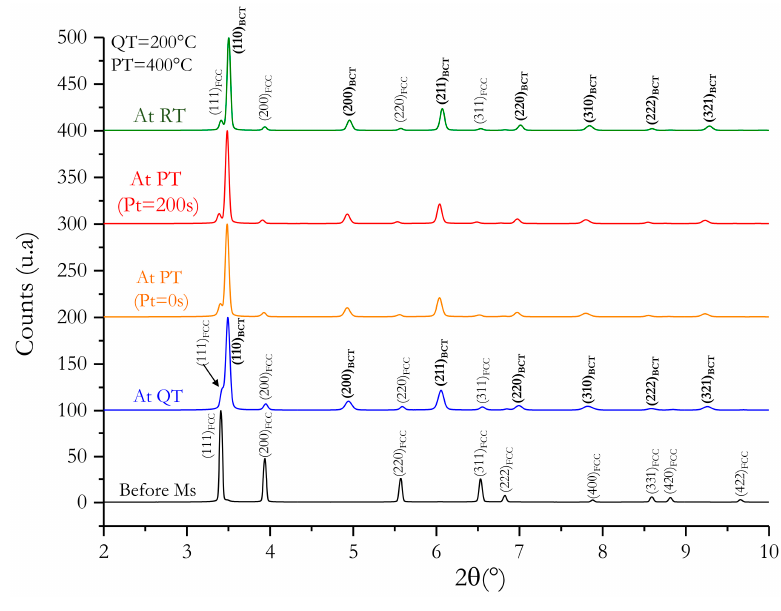
Figure 4. Di ff ractograms corresponding to the critical times selected in Figure